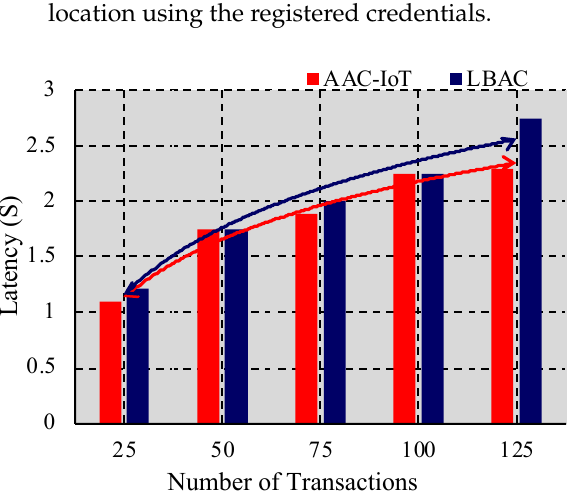
Figure 9. Performance of latency plot against transaction number.